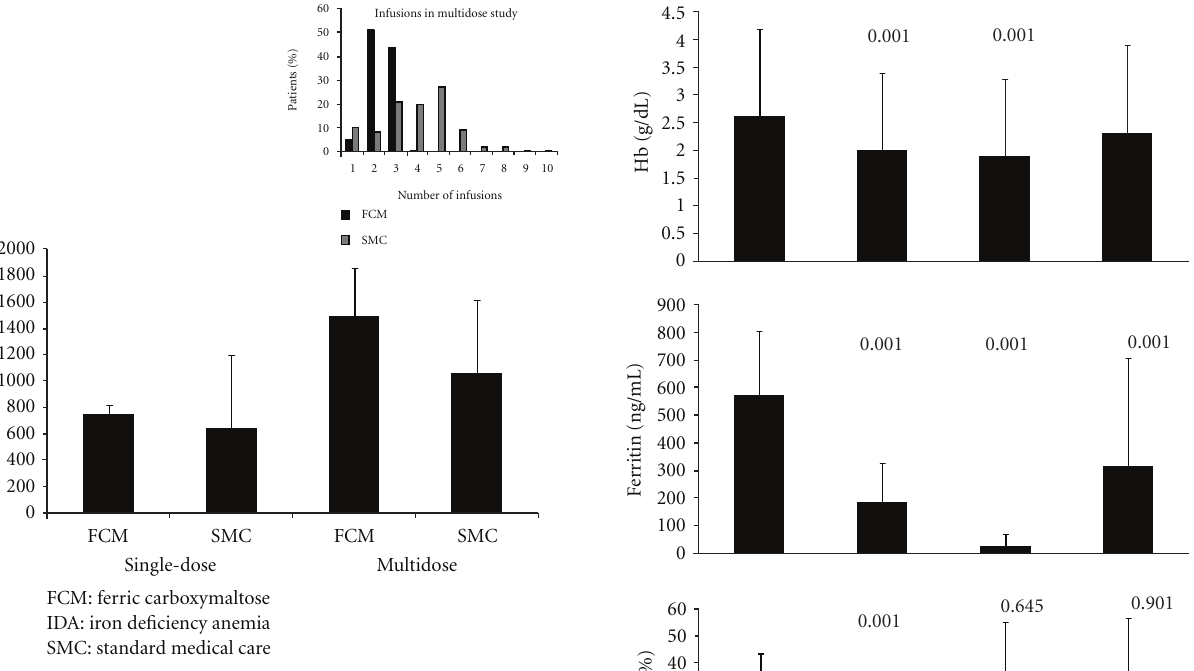
Figure 2: Extent of exposure to IV iron. Mean exposure with stan- dard deviations for the FCM and SMC groups in the single-dose and multidose studies. The mean maximum single infusion in the multidose study was 745 . 7 ± 45 . 1 mg in the FCM group and 380 . 1 ± 407 . 2 mg in the SMC group. The insert shows the number of infu- sions administered in the multidose study.